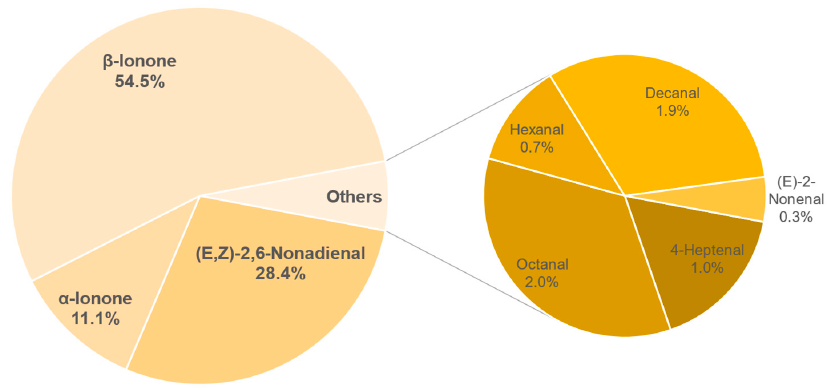
Figure 14. Percentage of OAV of each compound in the total aroma of sample 182.